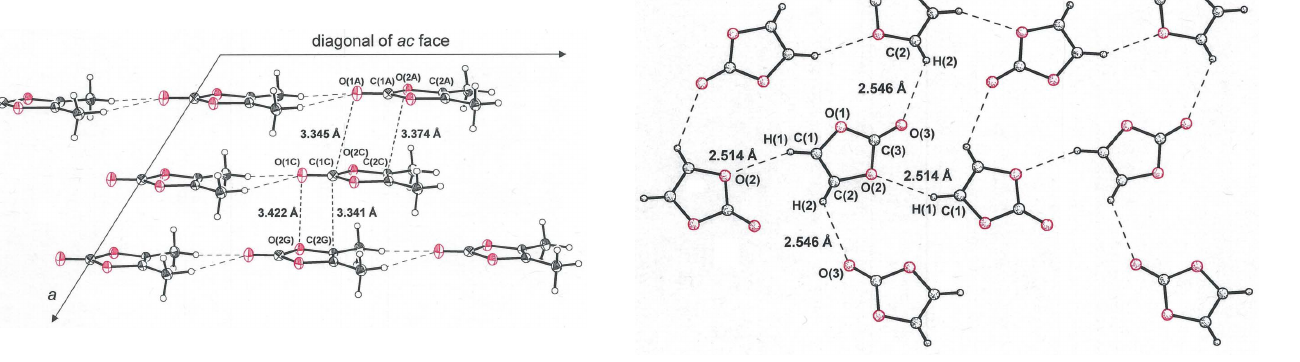
Figure 4 View of the cell packing arrangement in 1 depicting the closest intermolecular contacts between linear strands extending in the direction of a diagonal to the ac face. Displacement ellipsoids are at the 50% level.